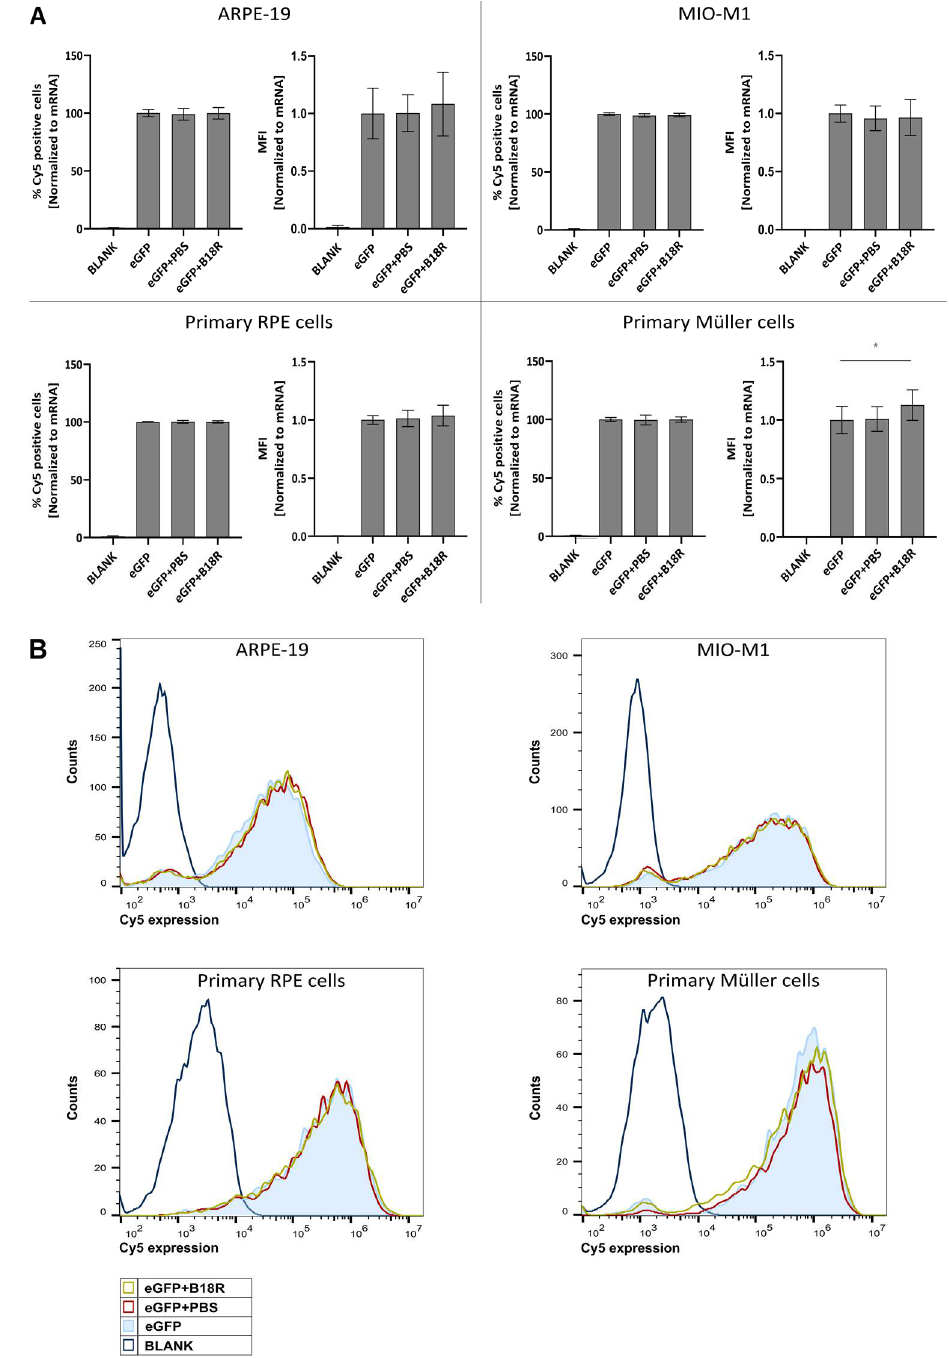
Figure 2. Uptake efficiency of mRNA-MessengerMAX complexes when co-incubated with B18R. ( A ) Data are expressed as the relative percentage of Cy ® 5 positive cells and relative MFI both normalized to the average value of the control group which received only mRNA-MessengerMAX complexes (eGFP) (n = 3 × 3). Other samples represent untreated cells (Blank) or cells co-incubated with PBS (eGFP + PBS) or B18R (eGFP + B18R) during transfection. Mean absolute percentage of Cy ® 5 positive cells was 84%, 96%, 95%, 98% for the ARPE-19 cells, MIO-M1 cells, primary bovine RPE cells and primary bovine Müller cells respectively (* p < 0.05). ( B ) Data represented as histograms obtained by flow cytometry.